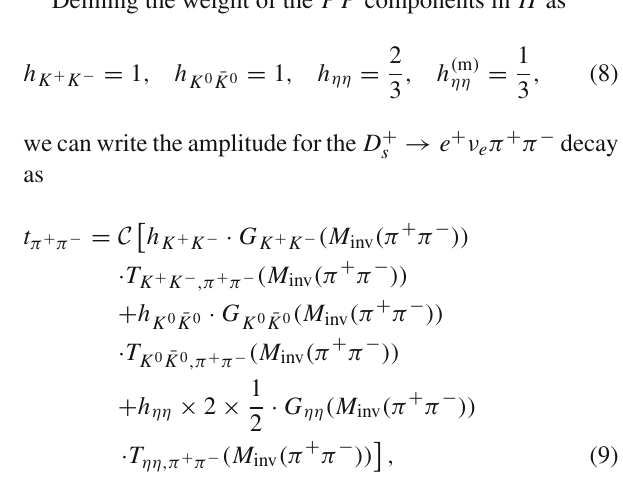
approach of Ref. [11] which produces very accurate meson- meson amplitudes from threshold to about 1200 MeV